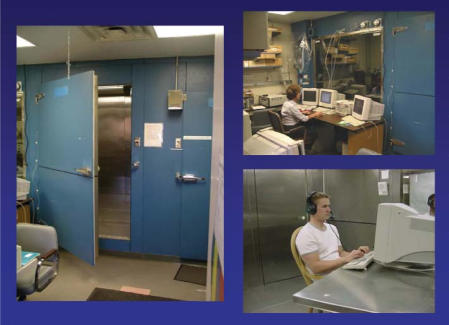
Controlled environment facility: technician and exposure stations.